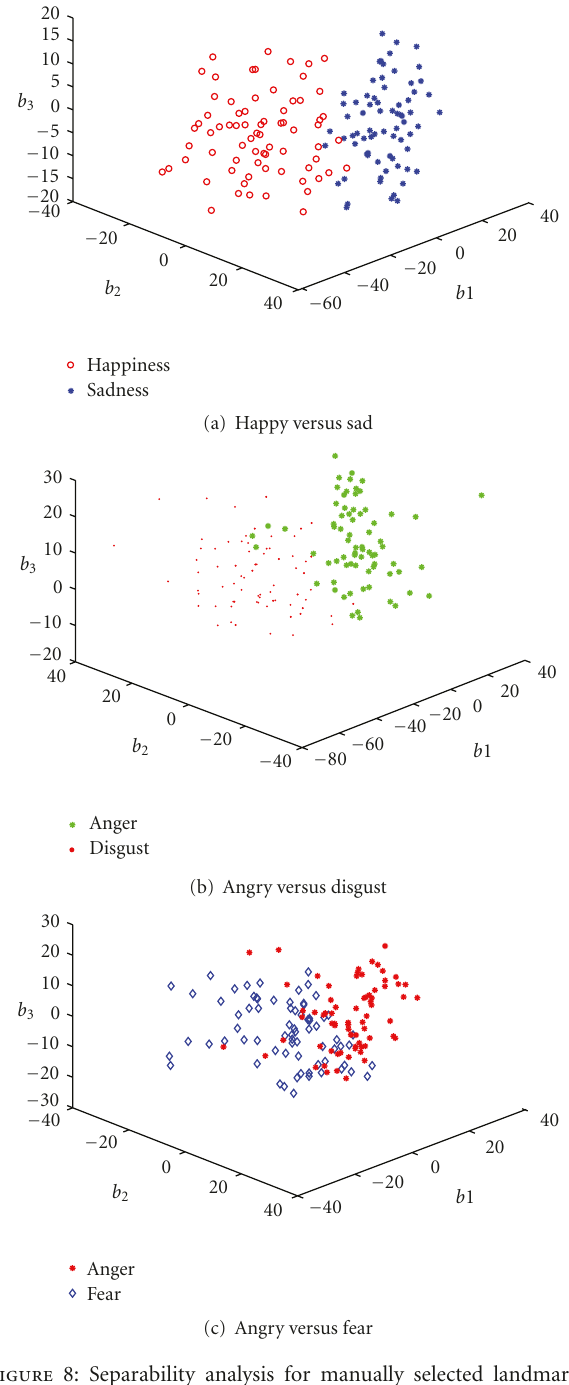
Figure 8: Separability analysis for manually selected landmarks using first three principal